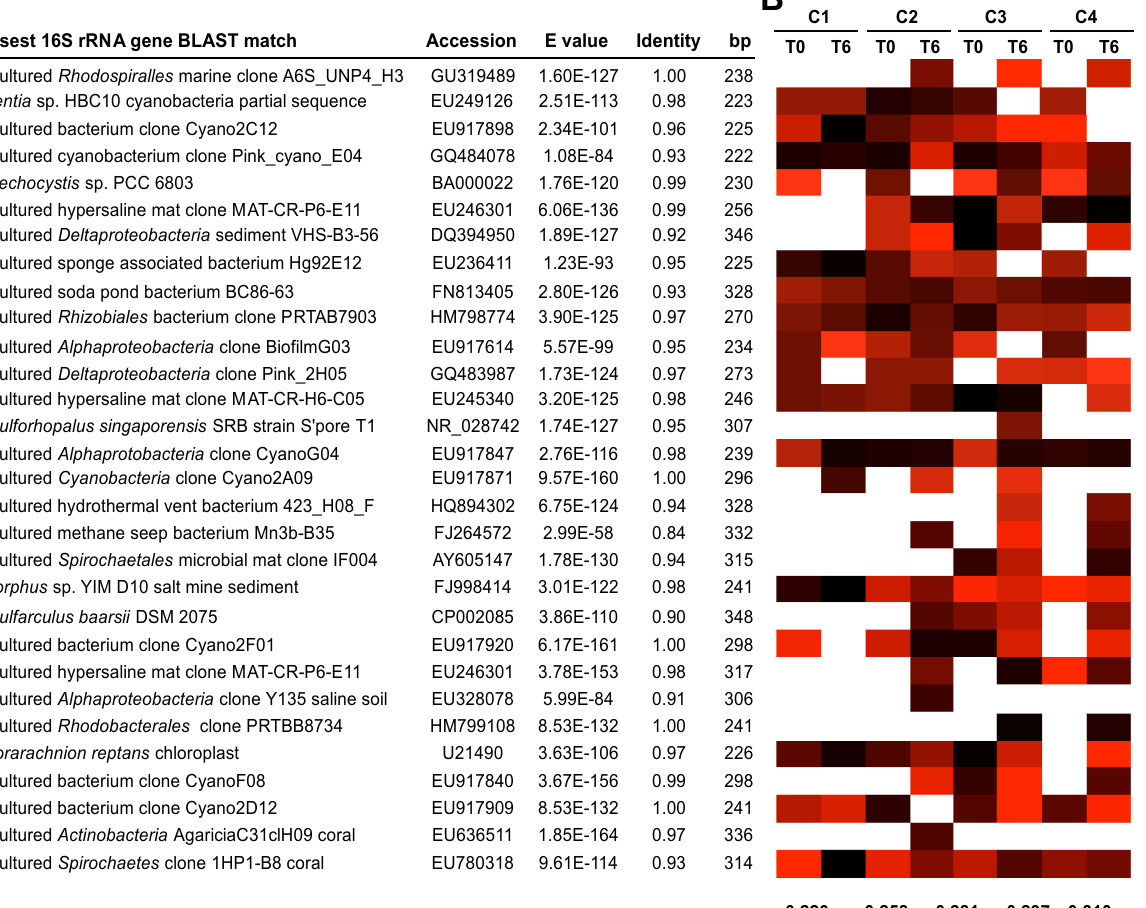
Figure 6. Changes in bacterial diversity of microbialites under elevated CO and salinity 2 treatments. (A) Basic Local Alignment Search Tool (BLAST) analysis of OTUs that represent >1% of total recovered 16S rRNA gene pyrosequencing reads; (B) Heatmap depicting changes in relative abundance during CO and salinity manipulations at 0 (T0) 2 and 6 (T6) months. Legend in lower right corner reflects colors associated with the relative abundance for each OTU within each treatment scaled at a log10 abundance value. White blocks indicate that an OTU was not found in a treatment. The environmental treatments and 35‰ salinity; C2, 1200 ppmv CO and 35‰ salinity; C3, include: C1, 400 ppmv CO 2 2 400 ppmv CO and 85‰ salinity; and C4, 1200 ppmv CO and 85‰ 2 2